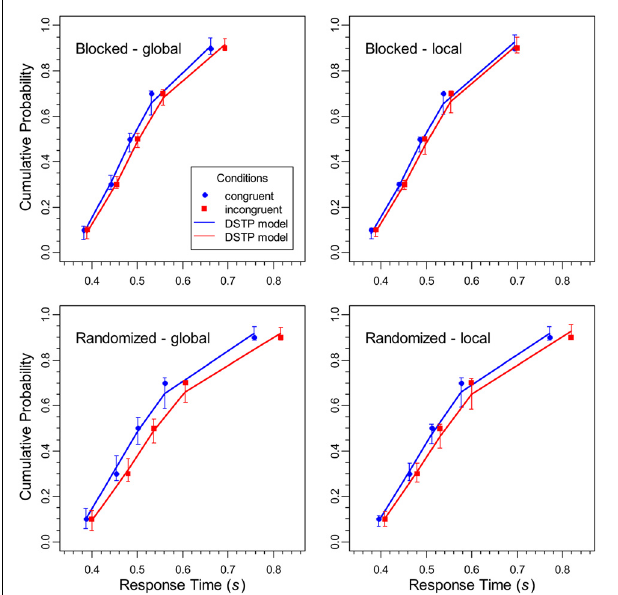
FIGURE 3 | The data points represent the cumulative distribution functions for the RTs of correct responses for the different conditions in the experiment, whereas the solid lines show the respective performance of the DSTP model. The error bars represent the 95%-confidence intervals of the theoretical function, estimated from the results of the jackknife